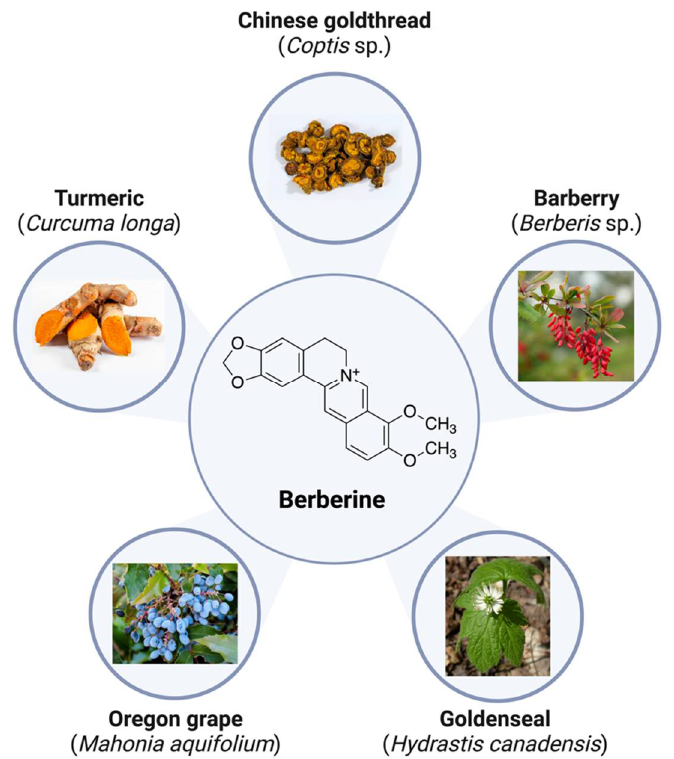
Figure 3. Chemical structure and sources of naturally occurring berberine (C 20 H 18 NO 4+